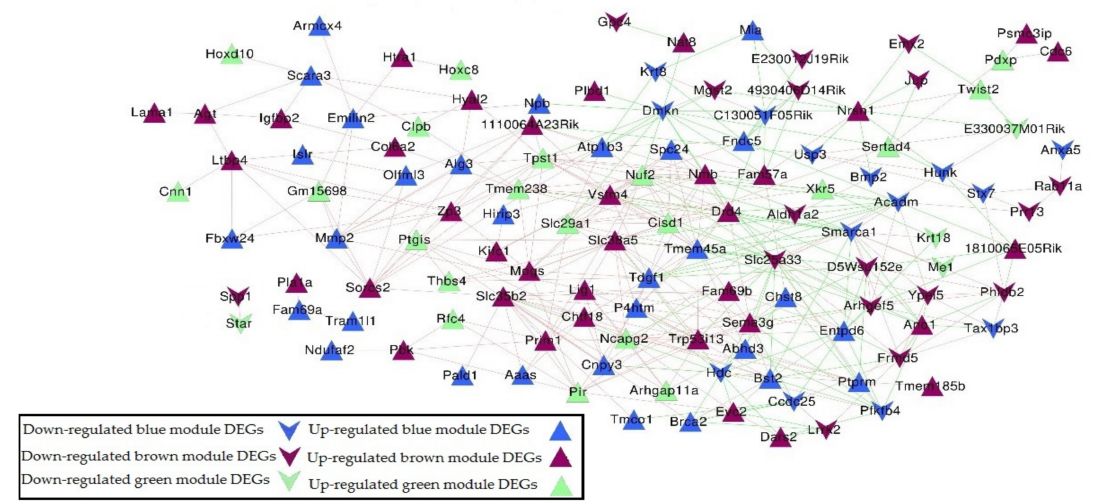
Figure 5. Gene co-expression network based on 153 DEGs in blue, green, and brown modules. Triangle and inverted triangle refer to up and down-regulated DEGs; blue, green, and brown nodes mean genes from the corresponding colored module. Redline connections mean a positive correlation coefficient, and green line connections mean a negative correlation